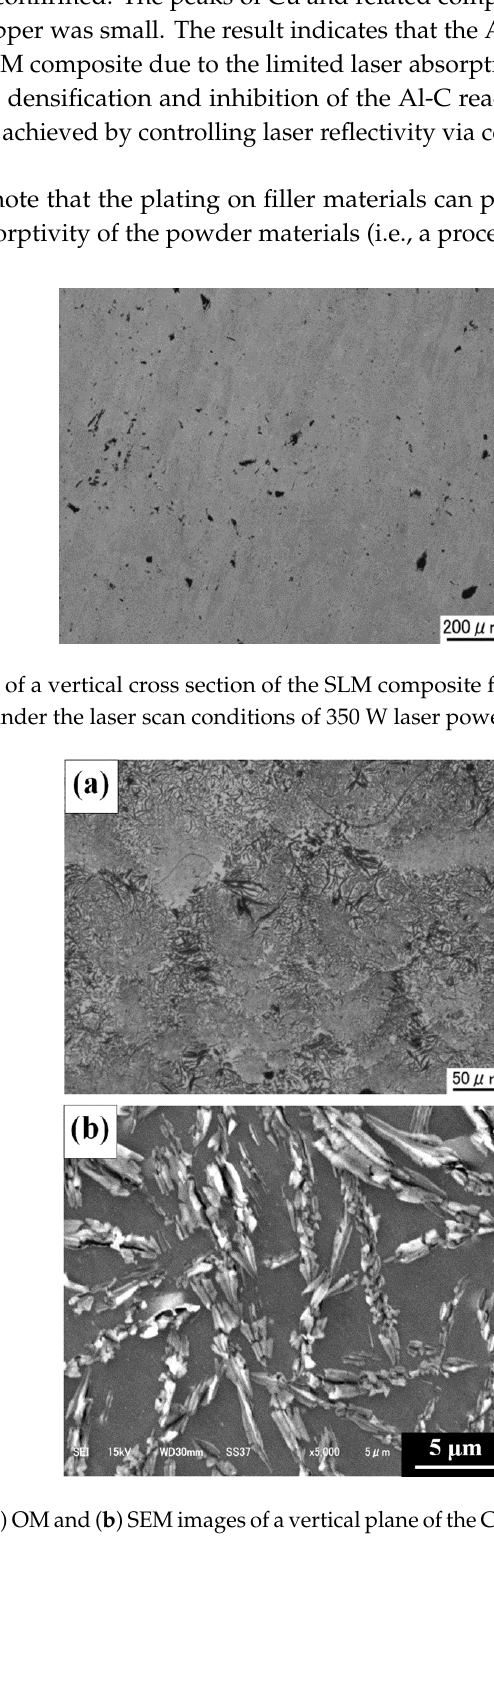
Figure 15. XRD pattern of Cu plated C/Al SLM composite. Figure 16 shows Vickers hardness and thermal conductivity of the Cu plated C/Al SLM composite and C/Al SLM composite. The hardness of Cu plated C/Al SLM composite is much higher than that of the C/Al SLM composite, although the thermal conductivity is unchanged. The strengthening can be attributed to additional solid-solution hardening by increased solid-solution copper in the α-Al matrix [41]. The unchanged thermal conductivity was due to increased solid- solution copper and residual copper plate on the carbon fiber. This led to the offset of any increase in thermal conductivity by residual carbon with a decrease in thermal resistivity by the solid-solution strain in the α-Al matrix and interfaces on the copper plate.